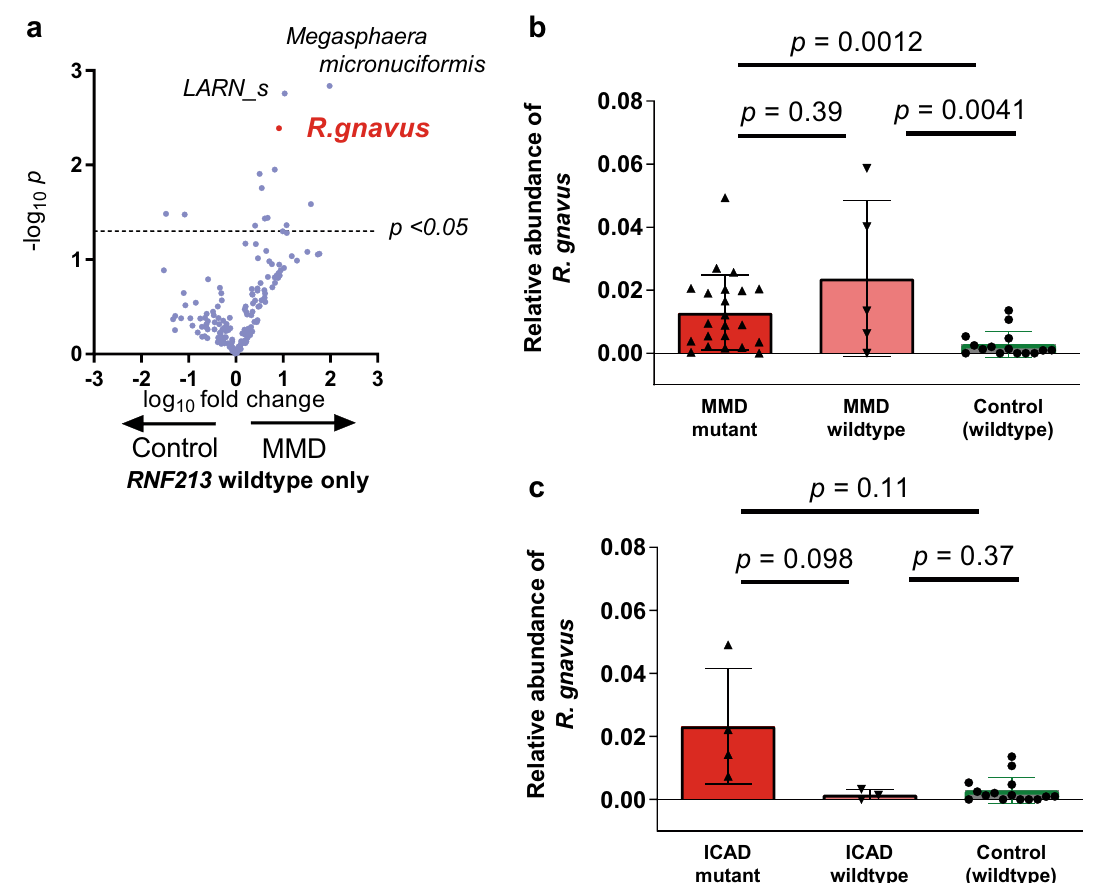
Figure 5. Stratification analysis of the RNF213 p.R4810K mutation to assess the effect of R. gnavus on MMD and ICAD. ( a ) To minimize the effect of the p.R4810K mutation in RNF213 gene, wildtype-specific analysis was performed. R. gnavus showed the third lowest p value as shown in the volcano plot. ( b ) There was no significant difference between RNF213 mutant and wildtype in the abundance of R. gnavus in patients with MMD ( P = 0.39). Bars and whiskers indicate means and standard deviations. ( c ) In patients with ICAD, those having the p.R4810K mutation showed a trend for higher relative abundance of R. gnavus than those without the mutation, but it was not statistically significant ( P =